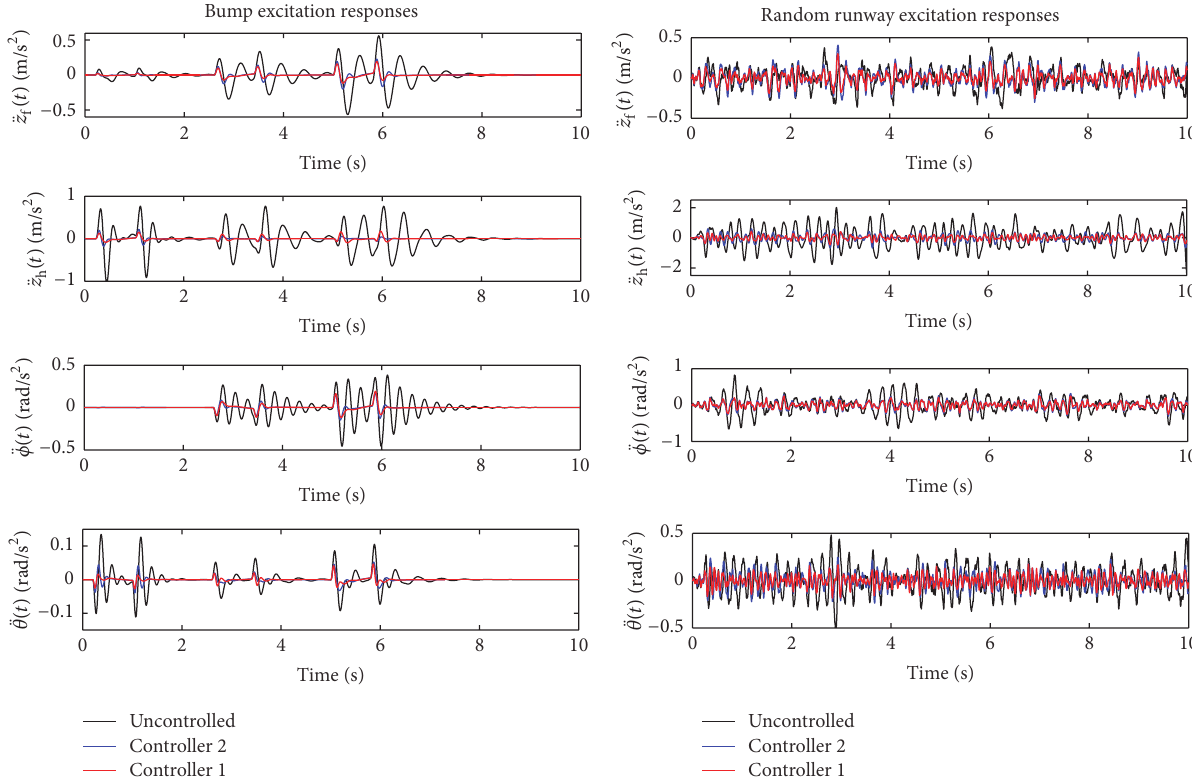
Figure 6: Controlled and uncontrolled acceleration time responses under bump and random runway excitation.